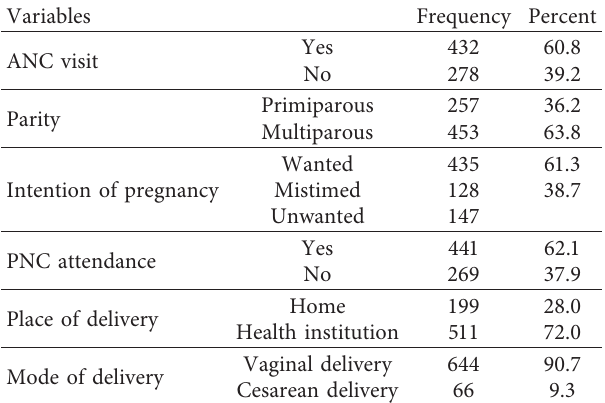
Table 2: Obstetric characteristics of the study participants among women in west Shoa zone.